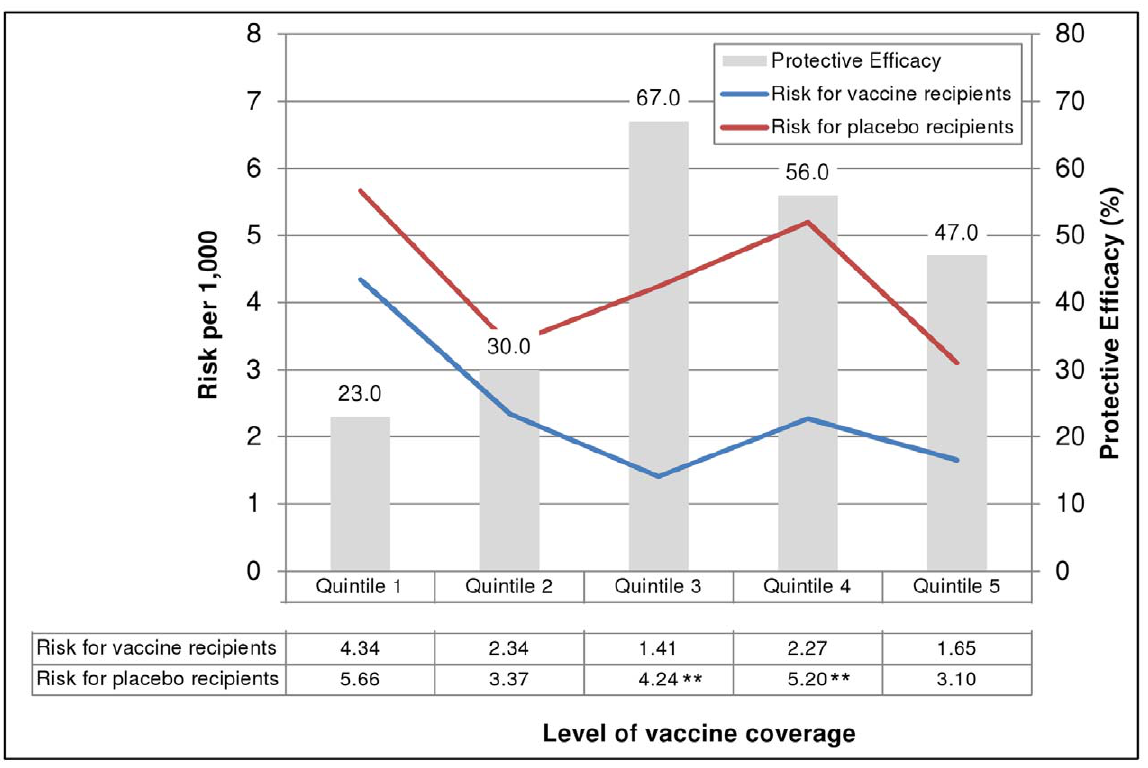
Figure 3. Risk of cholera and protective efficacy of killed oral cholera vaccines, by level of vaccine coverage in household-level social networks. ** p , 0.01 for the difference in risk between vaccinees and placebo recipients. Note: Quintile values are as follows: , 27.2%, 27.2- 40.0%, 40.1-50.0%, 50.1-62.5%, . 62.5%. GREY bars show vaccine protective efficacy by quintile of vaccine coverage within social networks developed using household-level kinship connections. The number shown above each bar is the calculated protective efficacy. The RED line indicates the risk of cholera for placebo recipients while the BLUE line indicates the risk of cholera for vaccine recipients by quintile of vaccine coverage within social networks. The numbers contained in the table below the graph indicate the calculated cholera risk for each group. An asterisk (**) indicate that the cholera risk per 1,000 was significantly different between the placebo and vaccine groups (e.g., the confidence intervals for the two calculated rates did not overlap). Quintiles show the proportion of a person’s social network that was vaccinated (e.g., for quintile 1, , 27.2% of people in an individual’s social network were administered the cholera vaccine).